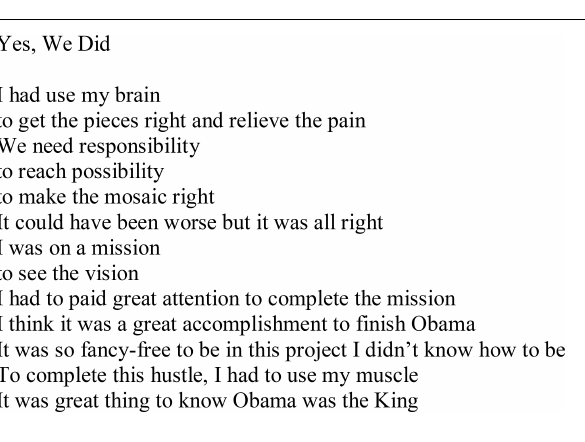
FIGURE 2 | Yes, We Did poem co-written by participants.